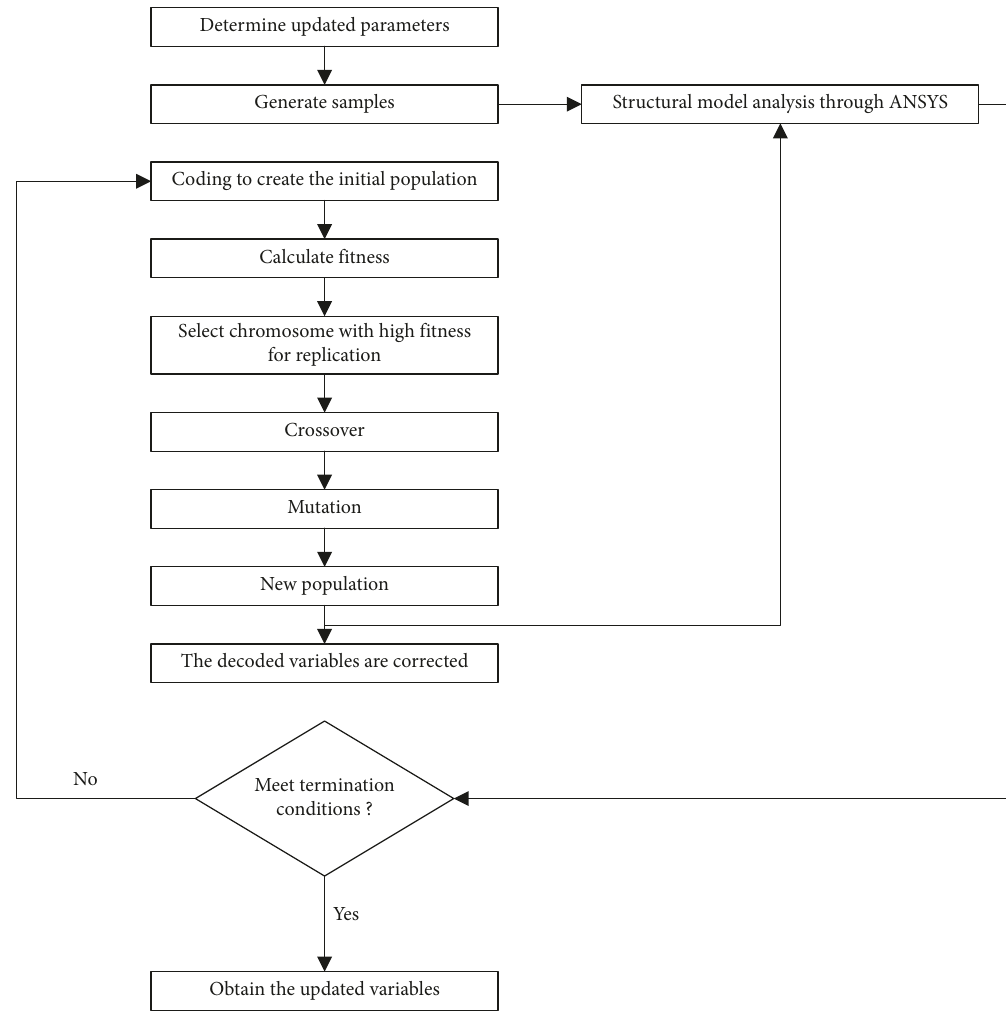
Figure 3: Flowchart of GA. Table 1: Comparison of truss updating results (unit: